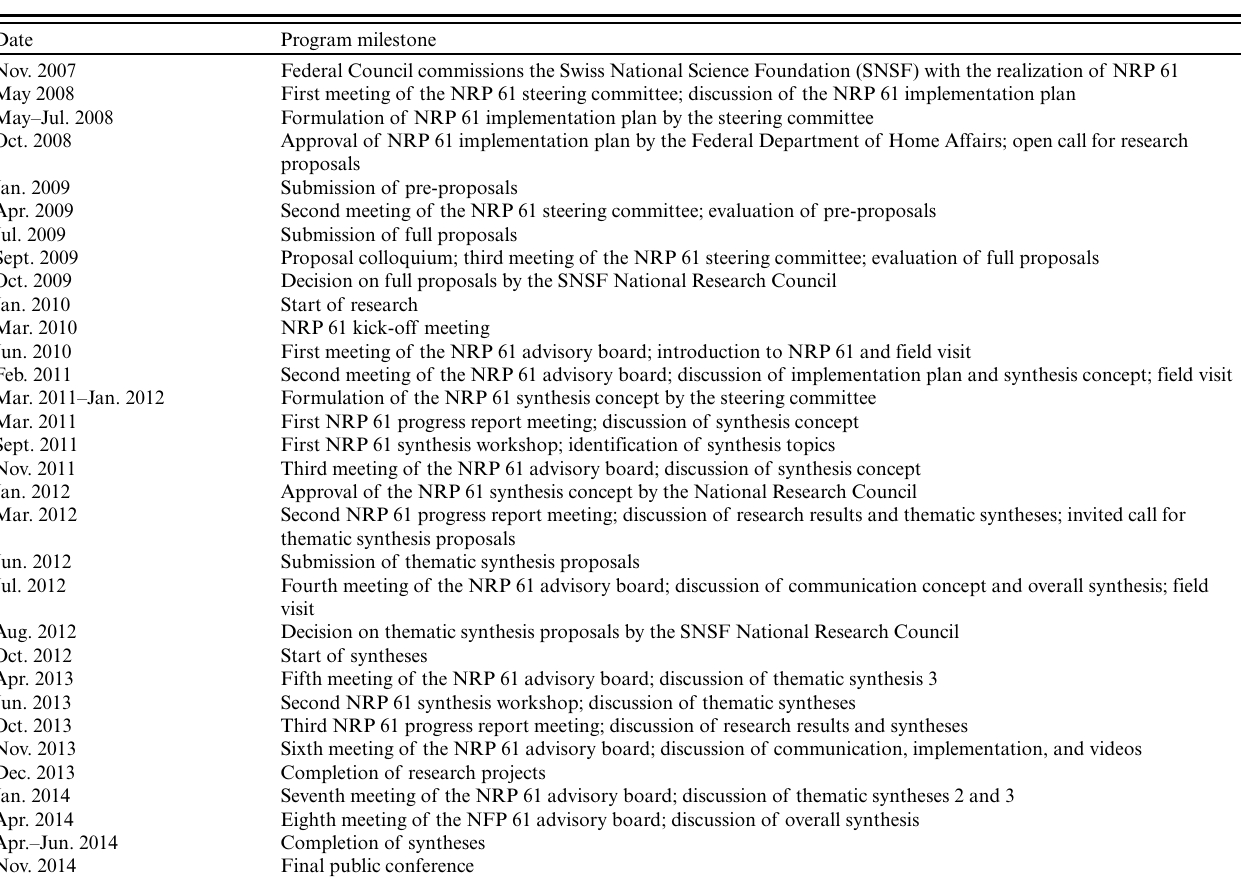
Table 1. National Research Programme 61 (NRP 61)